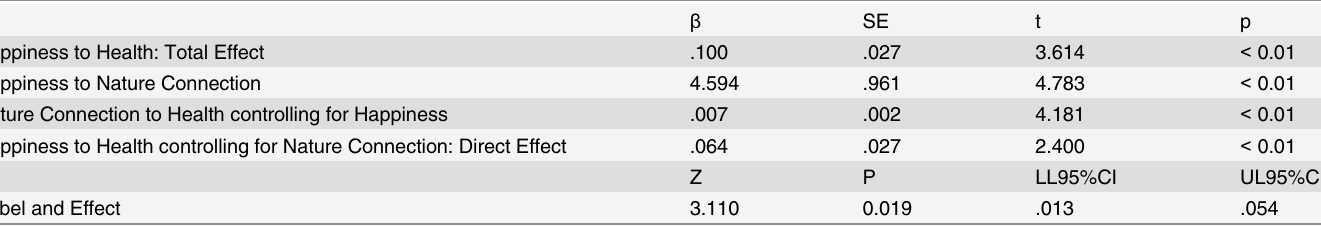
Table 5. Simple Mediation of the Indirect Effects of Happiness and Nature Connection on Health (5000 Bootstrap Samples). β SE t